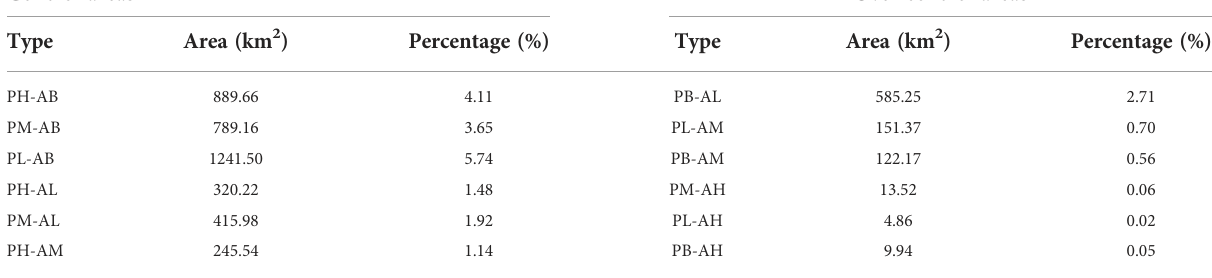
TABLE 4 Composition of control area and over control area.